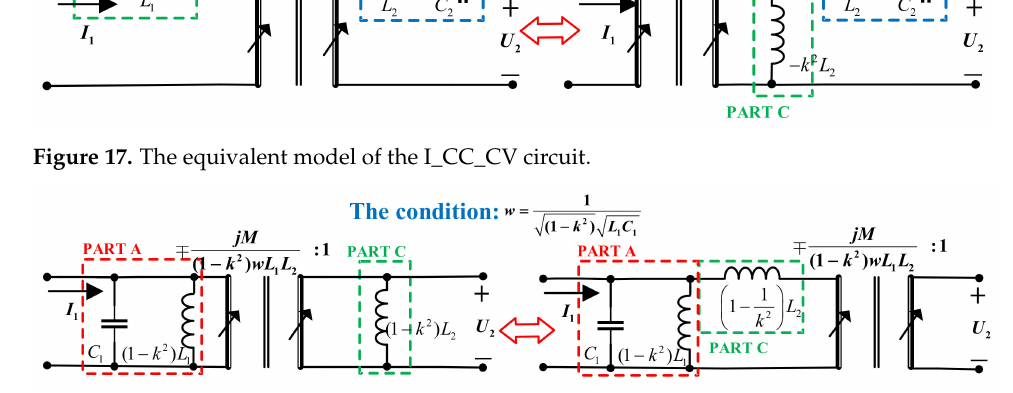
Figure 18. The equivalent model of the II_CC_CV circuit.